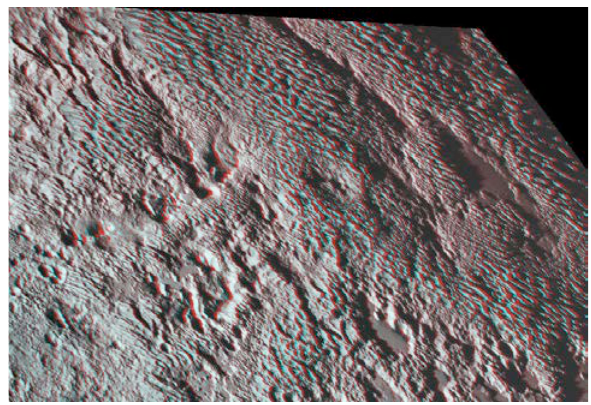
Figure 2a. A high-resolution 3d anaglyph of Pluto over “bladed terrain” along Pluto’s equator. Illustrating the very high quality of stereo products over this surface. The large ridged plateaus stand ~ 2 km high. Photoclinometry reveals relief of 100-200 m across individual ridges. Scene is ~500 km across.